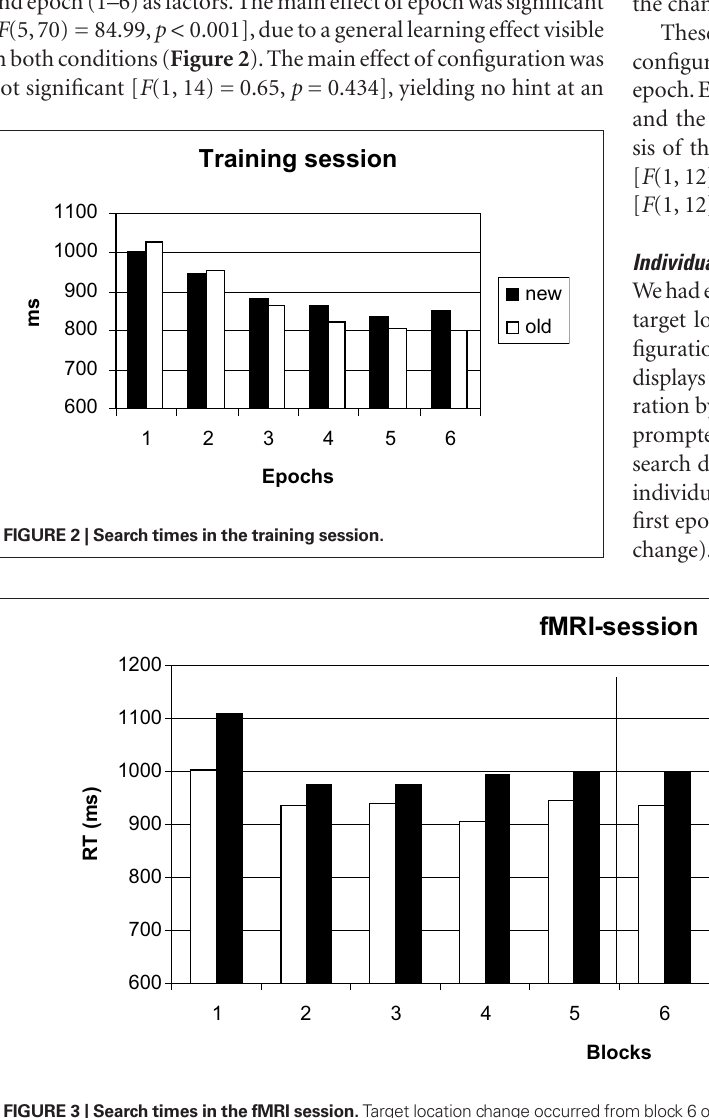
FIGURE 3 | Search times in the fMRI session. Target location change occurred from block 6